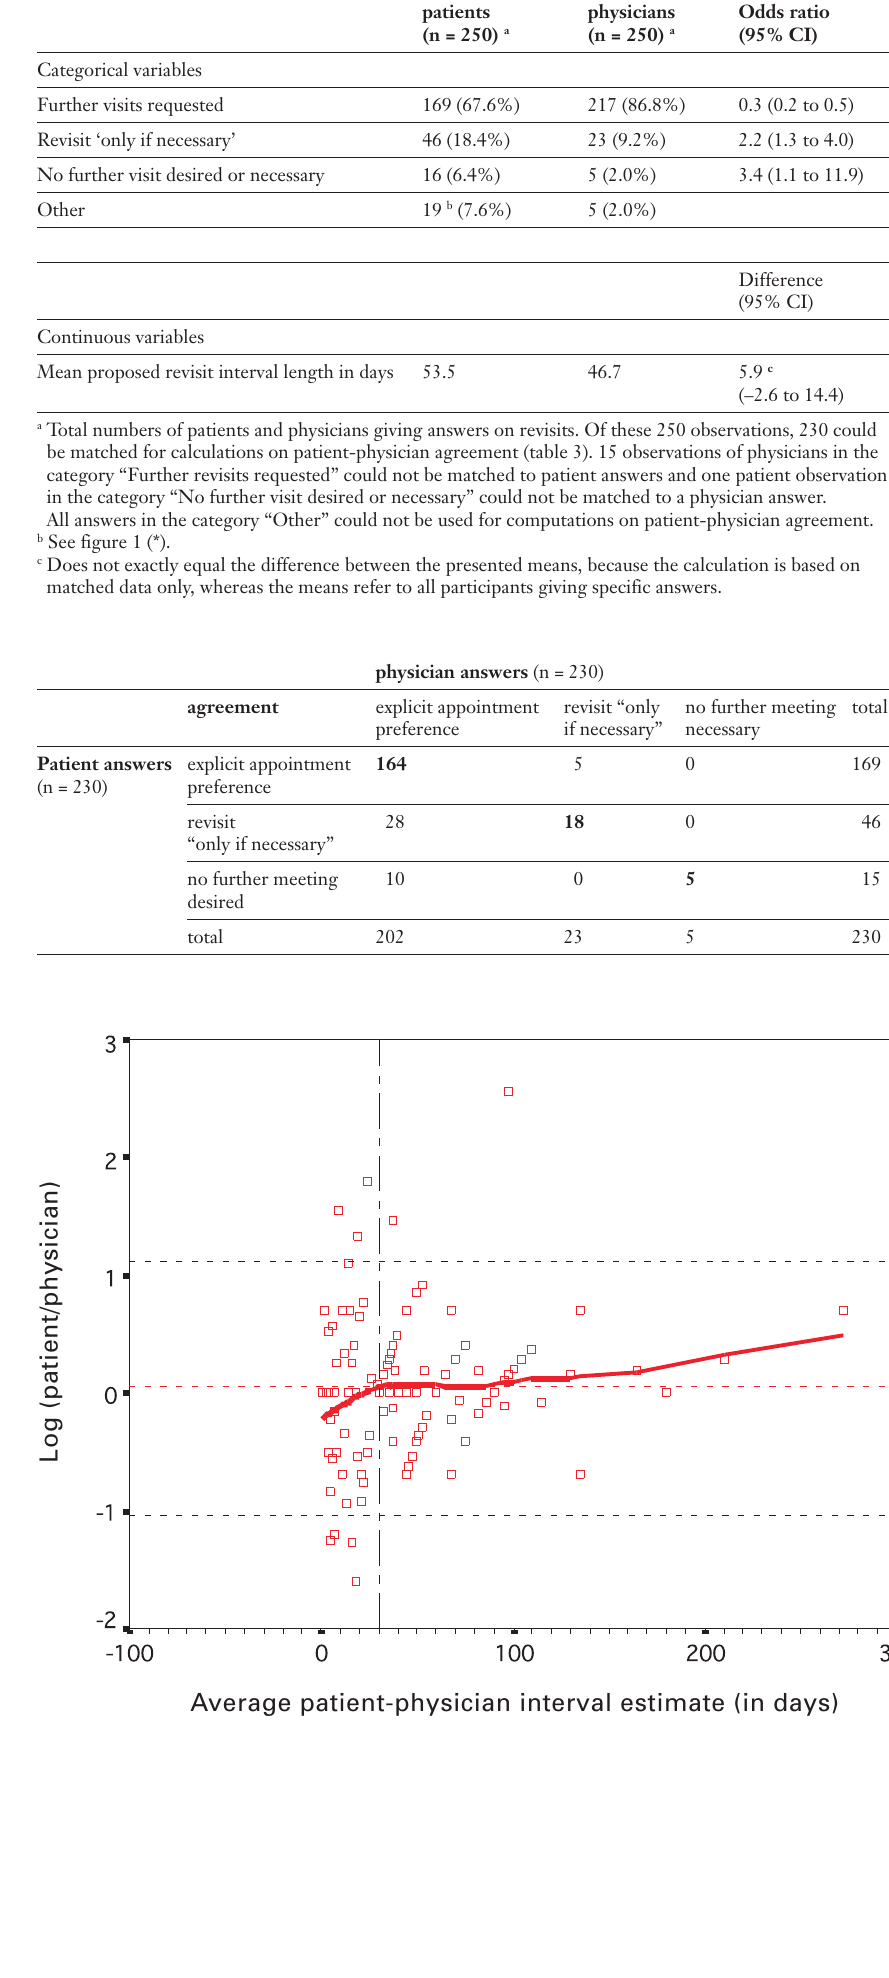
Summary of answers from patients and physicians.